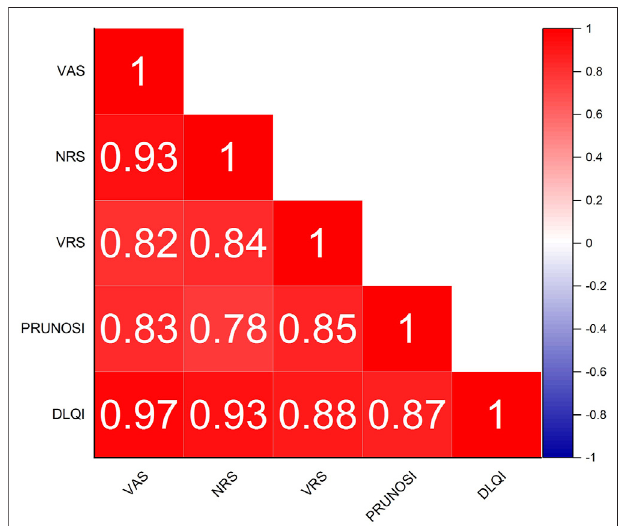
FIGURE 1 | A Spearman ’ s correlation coef fi cient (r) between the visual analogscale(VAS),numerical ratingscale(NRS),verbal ratingscale(VRS),the prurigoscore(PRUNOSI),anddermatologylifequalityindex(DLQI)amongthe PN patients ( n =